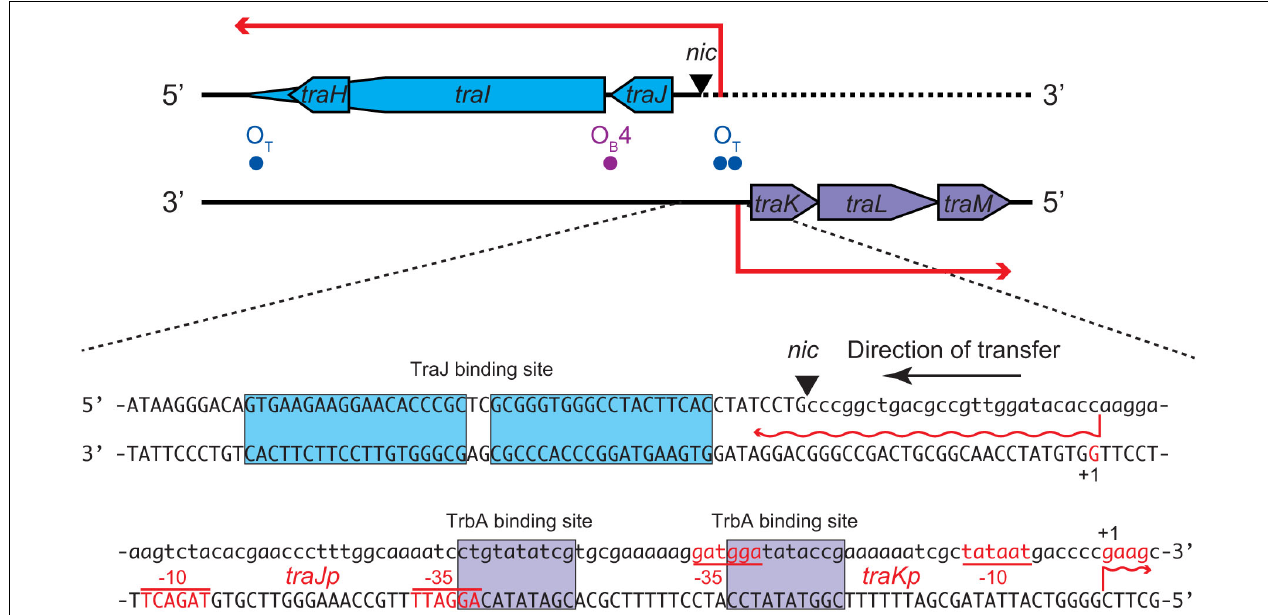
FIGURE 4 | Nucleotide sequence of the oriT region of RP4 plasmid. The nic site cleaved by TraI is indicated by the triangle. The nucleotides of the transfer strand which are transported into recipient first are written in lowercase. The transcription start sites and promoter sequences as previously reported (Zatyka et al., 1994) are indicated as +1, –10, and –35, respectively, on each non-template strand. The TraJ and TrbA binding sites are boxed. The binding site of TraK is located downstream of traK transcription start site (not shown).